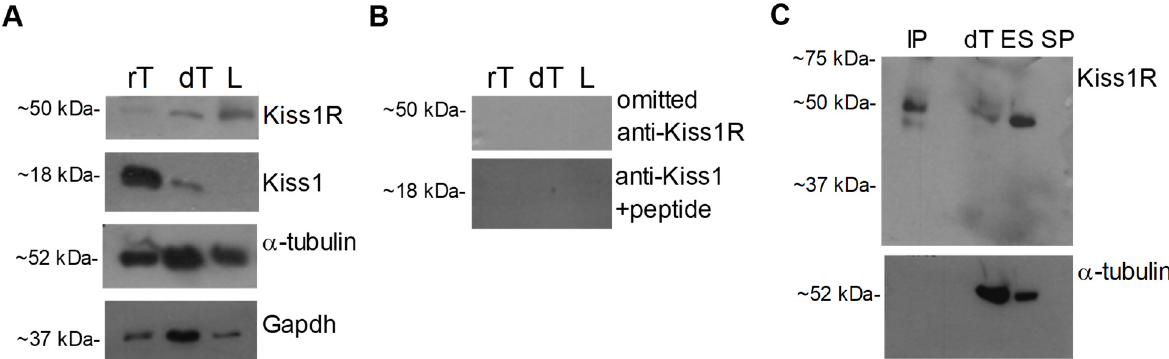
Figure 1. Kiss1R and Kiss1 proteins in dog tissues and Western blot specificity assay. ( A ) Western blot carried out in tissues. ( B ) The specificity of the ~18 kDa Kiss1 band observed in tissues was assayed using the anti Kiss1 antiserum preadsorbed with a five-fold excess of the corresponding antigen. The specificity of the ~50 kDa Kiss1R band was assayed omitting the primary antiserum in Western blot and ( C ) by immunoprecipitation of total proteins (300 µg) extracted from dog testis. dT: dog testis; IP: immunoprecipitation; L: cauda epididymis ligament; rT: rat testis; ES: epididymis sperm (10 µg protein for tract). N = 3–4.